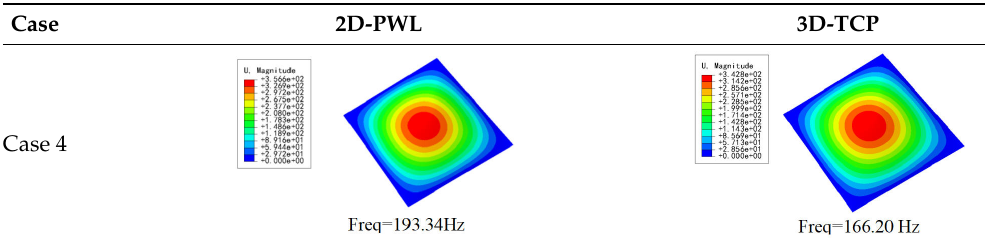
Table 17. Comparison of the first vibration modes and natural frequencies (Hz) predicted by 2D-PWL and 3D-TCP under different boundary